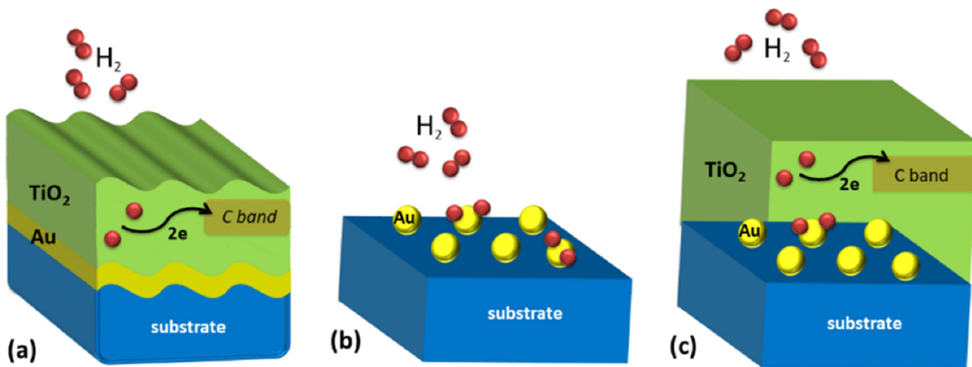
Figure 8. Schemes of the possible processes responsible of H 2 gas sensing response. ( a ) In the grating-based sensor at 300 ◦ C operative temperature, the H 2 dissociates on TiO 2 active sites and electrons are released into the TiO 2 Conduction Band. ( b ) For LSPR based sensors made of Au NPs at 300 ◦ C operative temperature it is possible to have H 2 dissociation directly on the Au NPs. ( c ) When the TiO 2 layer is deposited over the Au NPs monolayer, it is possible to have both H 2 dissociation on TiO 2 active sites and on the Au NPs.